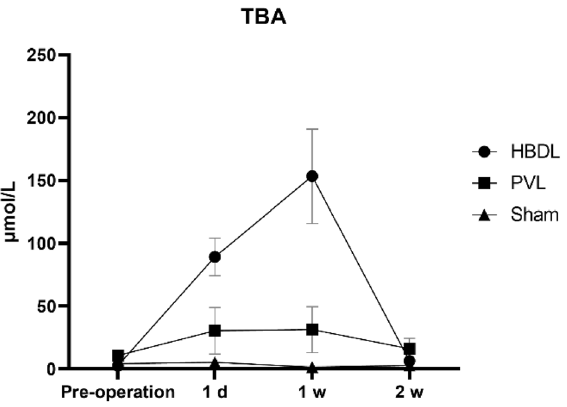
Figure 2. Serum bile acid levels in the three groups of rabbits at different time